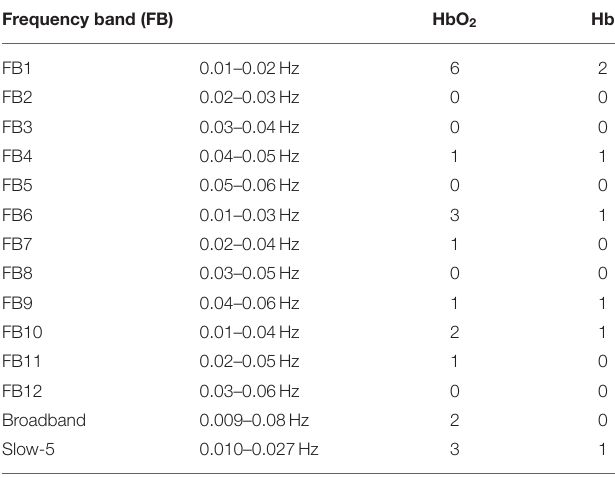
TABLE 1 | The number of channel pairs with significant difference in RSFC between ASD and TD in each frequency band for HbO 2 and Hb, respectively. Frequency band (FB) HbO 2